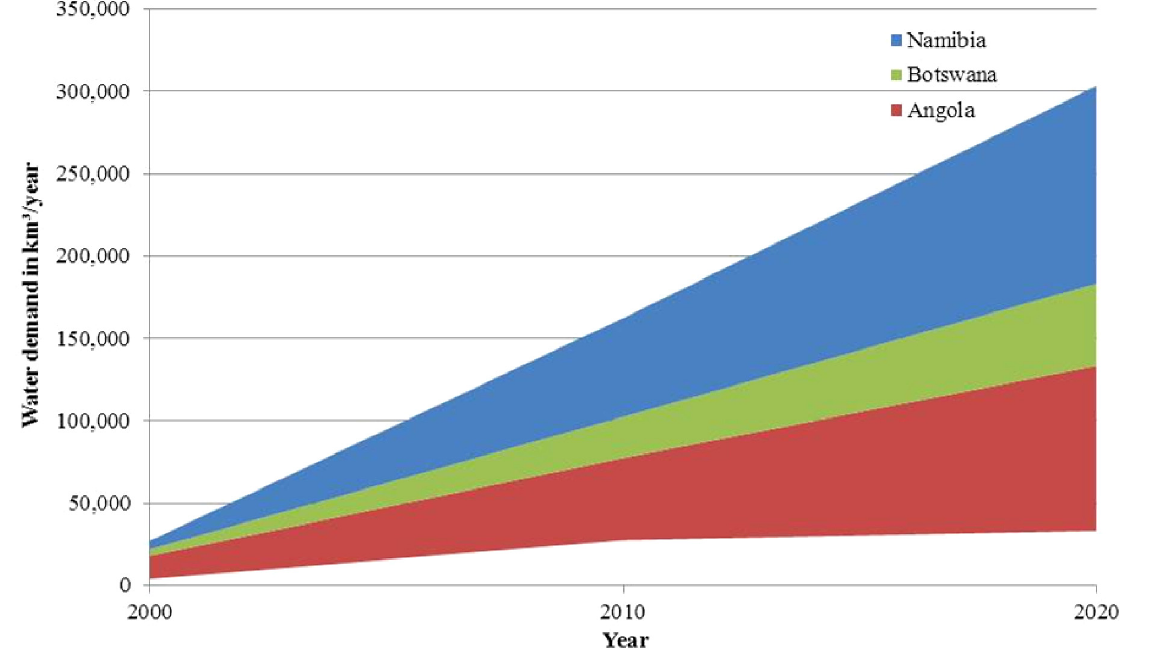
Figure 5. Projected growth in consumptive water demand (own representation based on data from